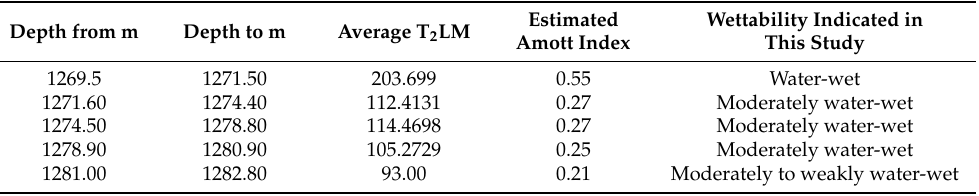
Figure 10. Cross-plot correlation between water saturation and NMR T 2 LM showing the trends in different oil intervals. Table 6. Re-evaluation of wettability conditions for core samples based on the criteria used in this study.